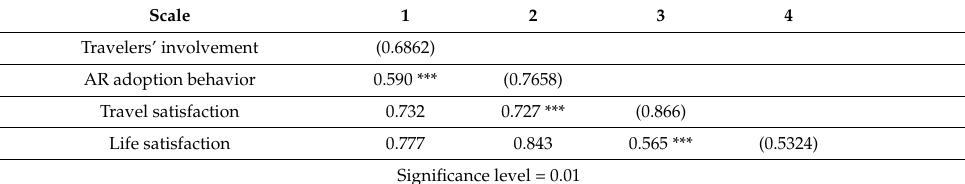
Table 4. Correlation matrix.